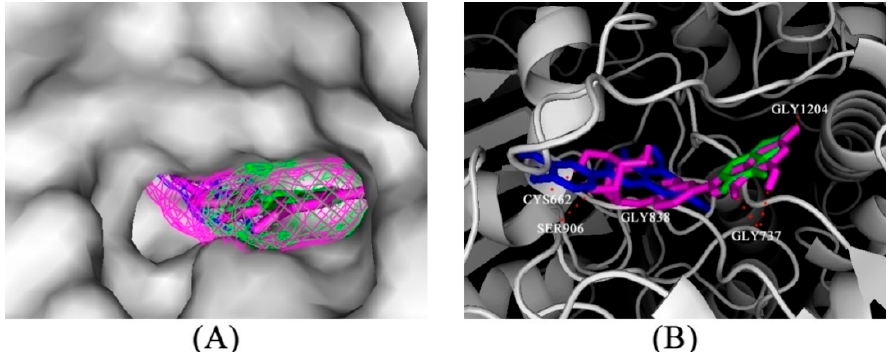
Figure 6. ( A ) Predicted binding mode of luteolin-4 ′ - O -glucoside (pink), luteolin (blue), and allopurinol (green) docked into XO using the Autodock 4.2 software (Molecular Graphics Laboratory, La Jolla, CA, USA); ( B ) The interaction between luteolin-4 ′ - O -glucoside (pink), luteolin (blue), allopurinol (green) and XO. The dashed lines (red) represent hydrogen-bonding interactions between luteolin-4 ′ - O -glucoside (pink) and XO.